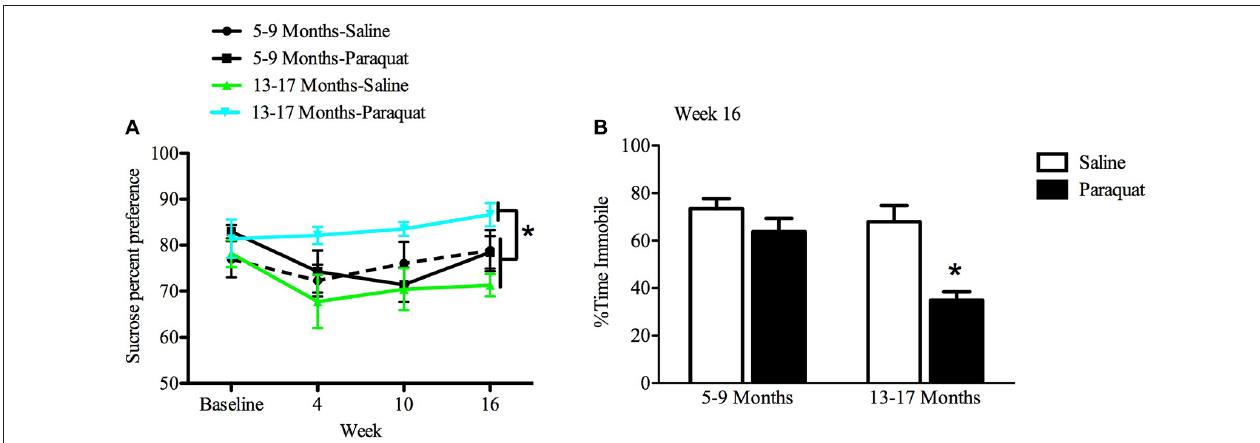
FIGURE 7 | Effect of long-term (low dose) paraquat treatment and age on sucrose preference and forced swim performance. As depicted in (A) , paraquat treatment augmented sucrose preference in the older cohort (13–17 months) relative to the remaining three groups. In contrast, the younger cohort of mice (5–9 months) that received paraquat (black line) did not differ from their saline treated counterparts (dotted black line) or saline treated aged animals (green line). Time spent immobile in the FST is shown in (B) . The older cohort of mice exposed to the low dose, chronic paraquat regimen (right black bar) spent significantly less time immobile than the other three groups. ∗ p < 0.05 relative to all other groups.